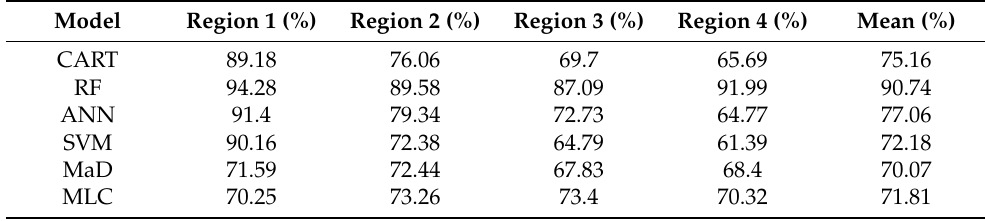
Table 5. Classification accuracy and mean value of each model in the study